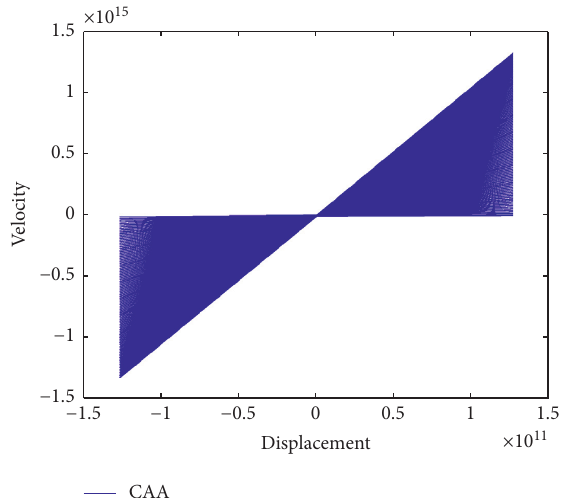
Figure 31: Phase portrait of the hardening spring calculated using the CAA method when Δ t � ( 1/2 ) T